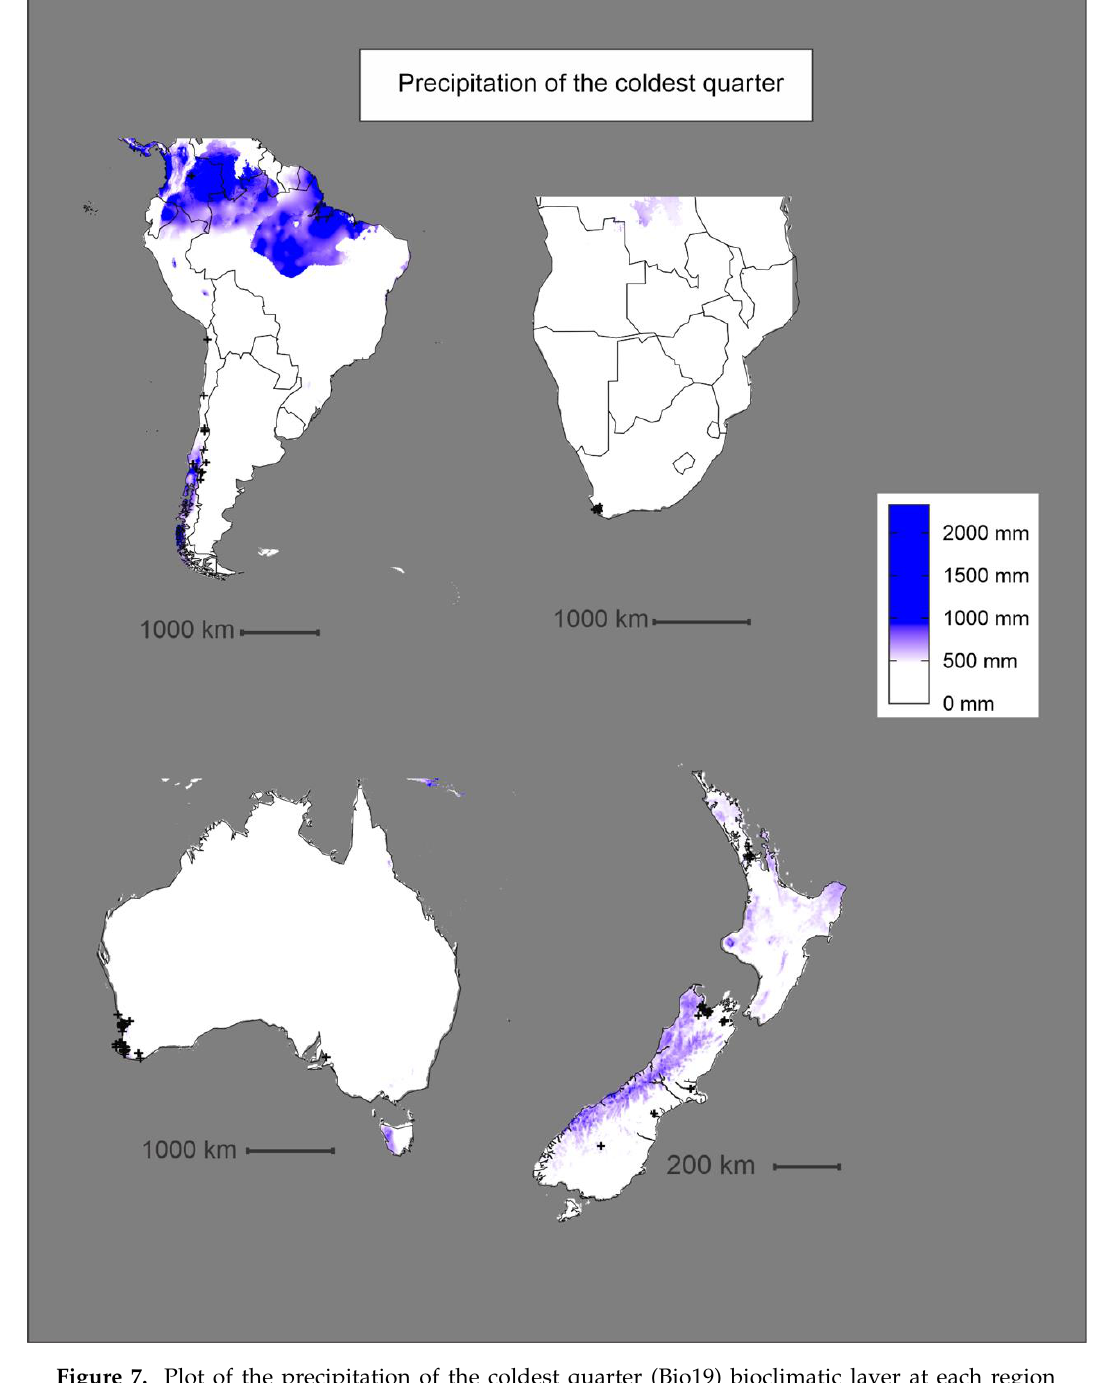
Figure 7. Plot of the precipitation of the coldest quarter (Bio19) bioclimatic layer at each region highlighted in this study. This variable had the second highest permutation importance of 15.9%. Black crosses indicate known occurrences of P. dominula.